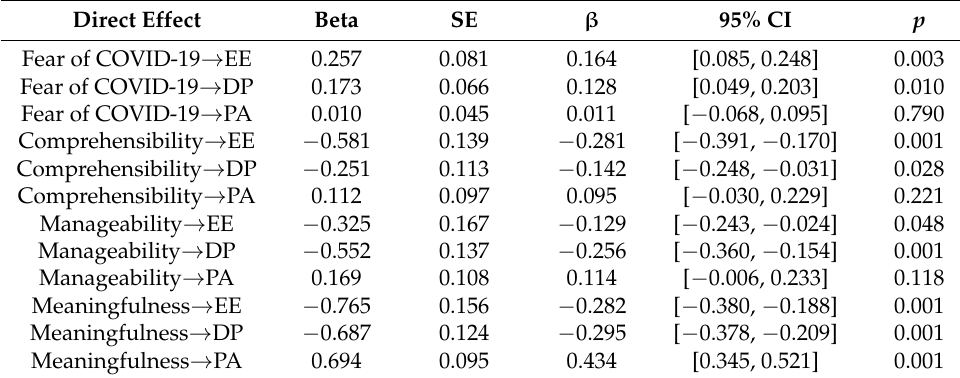
Table 2. The direct effects of fear of COVID-19 and sense of coherence on burnout.